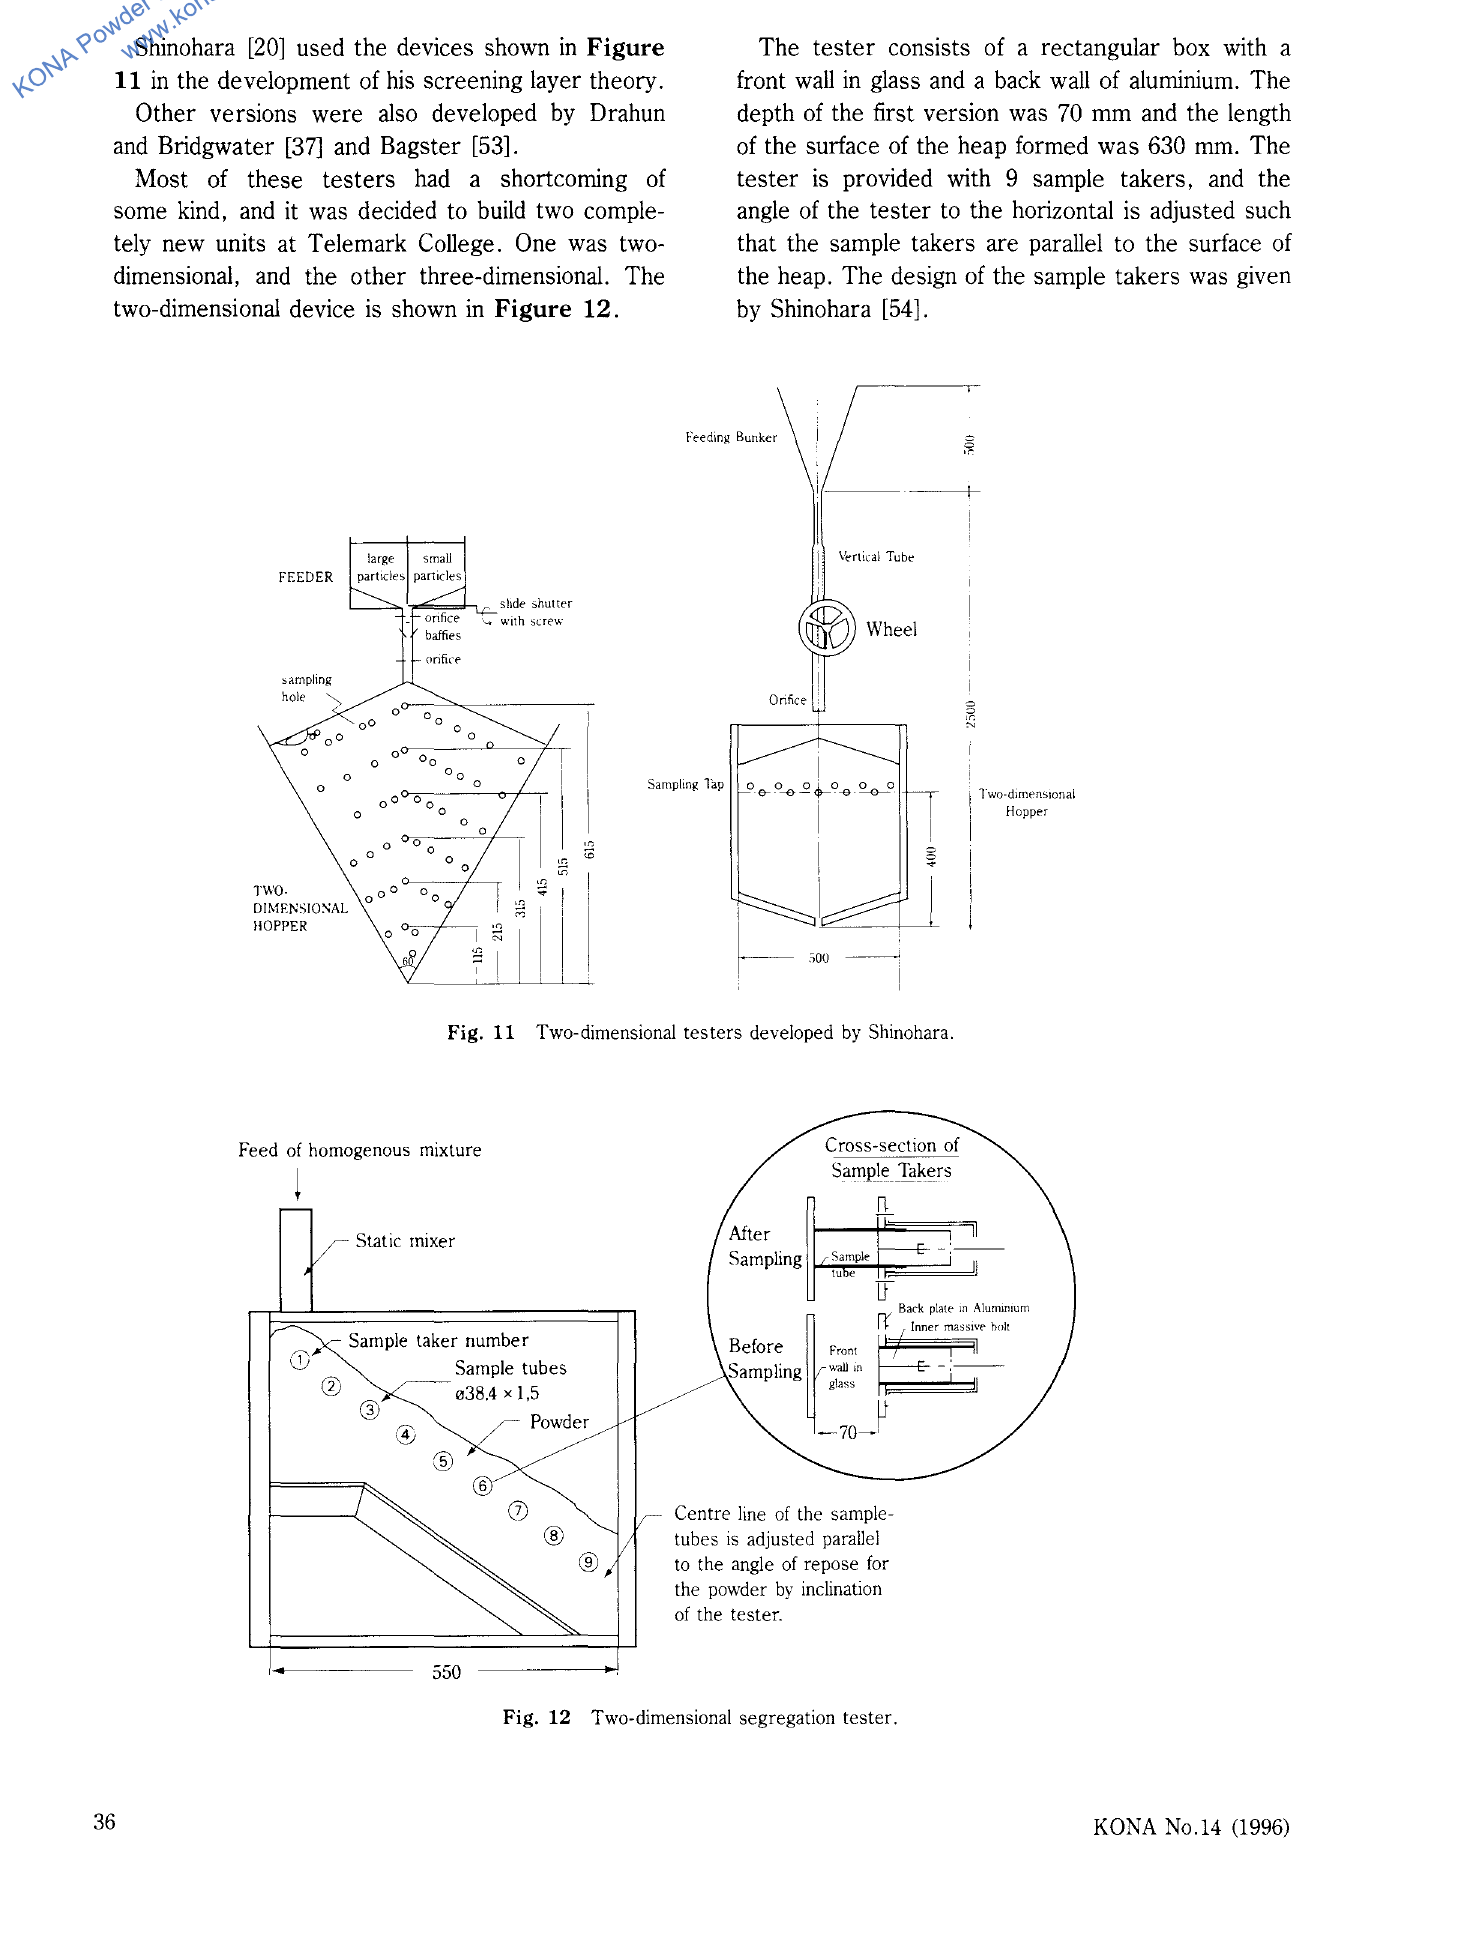
Fig. 12 Two-dimensional segregation